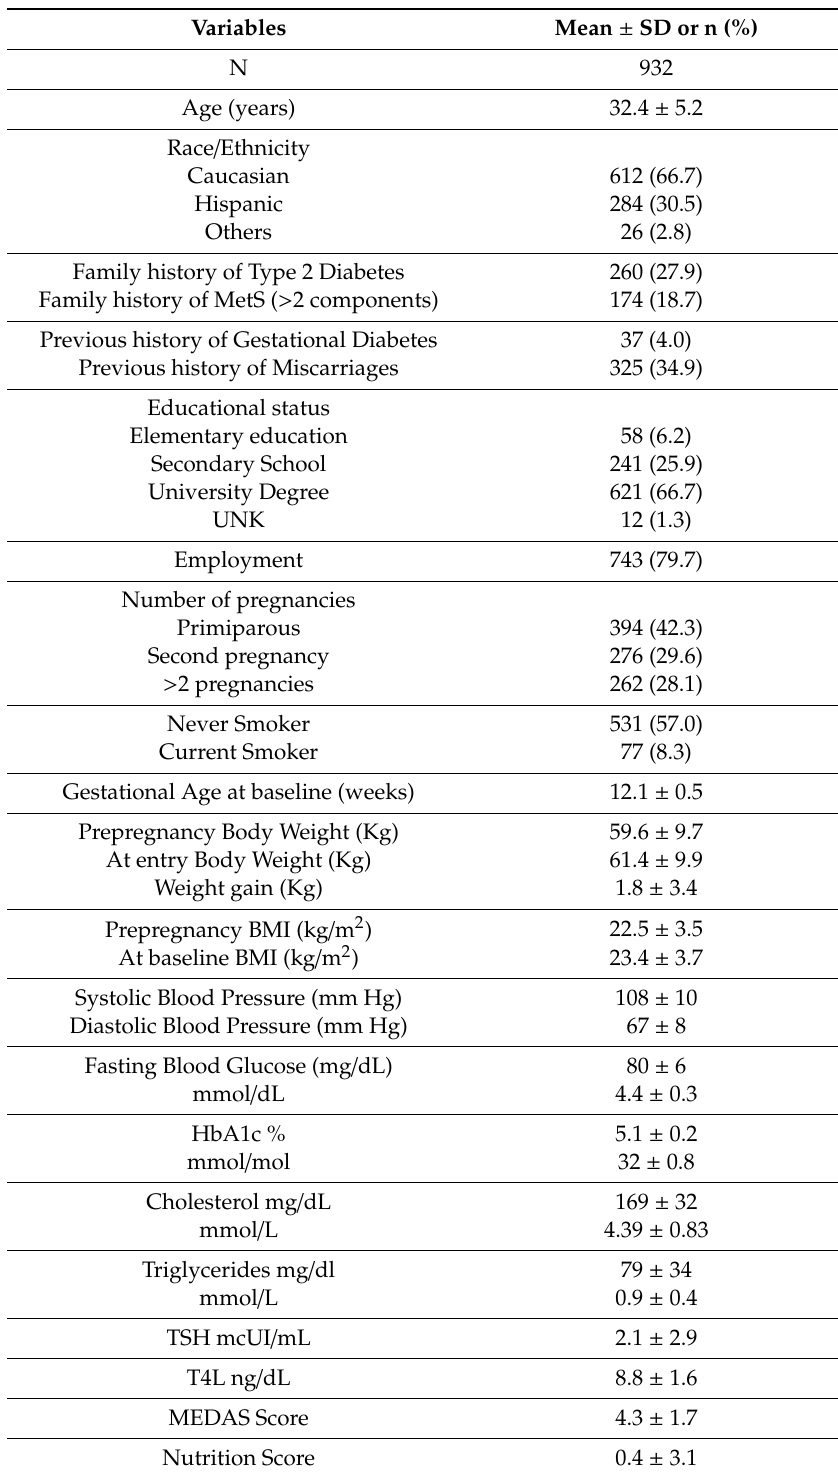
Table 1. Characteristics of the clinical trial population at